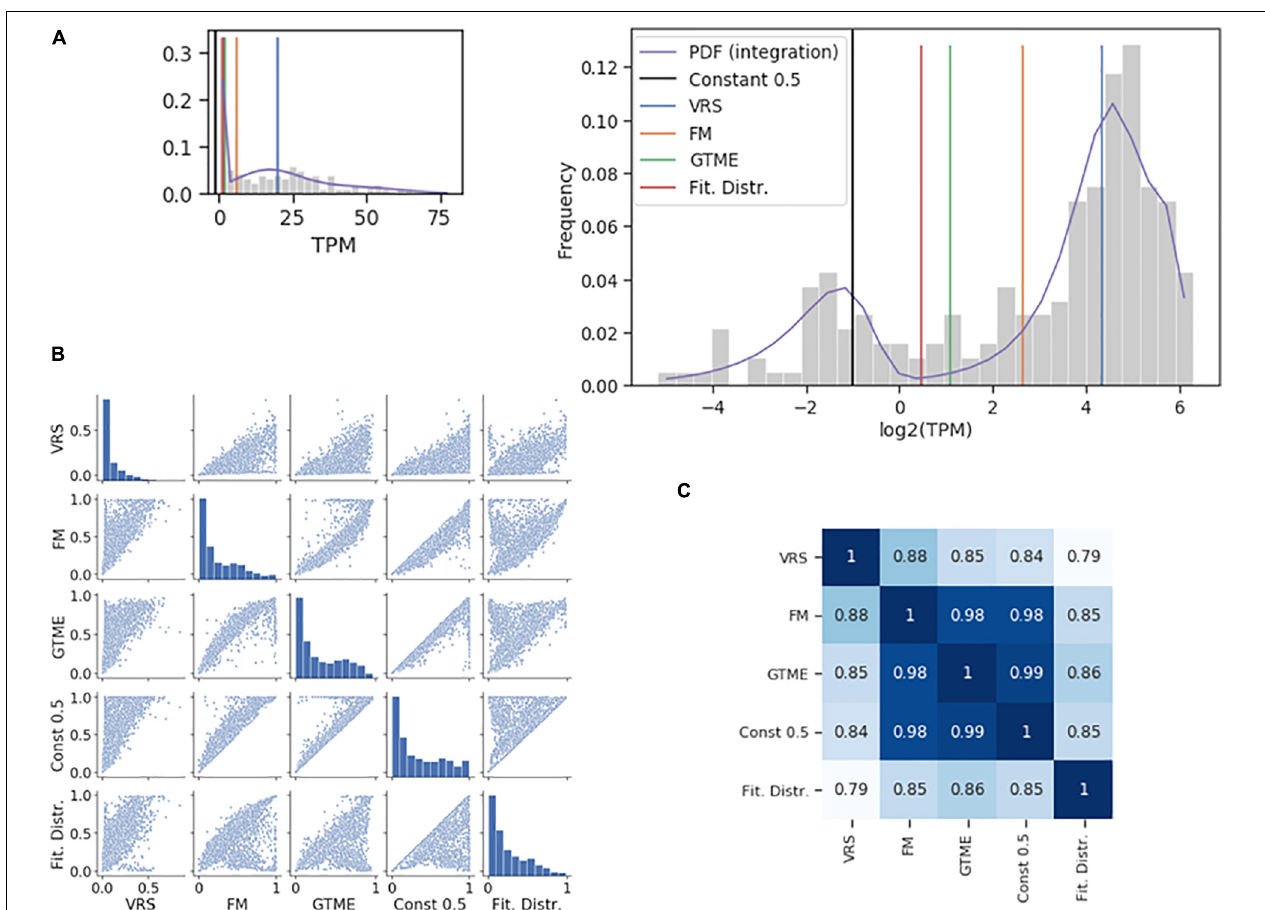
FIGURE 1 | Comparison of dichotomization methods. (A) The histogram of the Pcdhac2 transcript numbers in the somatosensory neurons. The dichotomization yielded the following thresholds: 2.11 (GTME), 6.28 (FM), and 20.21 (VRS) TPM. The fitted probability density function (pdf) is a mixture of normal distributions, with an antimode at 1.37. The pdf is integrated piecewise according to the logarithmic bins. The thumbnail plot is a version of the main plot with a linearly scaled x -axis. (B) Pair-wise scatter plots showing the ON cell frequencies of each gene in the somatosensory neuron dataset with a bimodality coefficient greater than 0.55, after dichotomization with different methods. (C) The Spearman rank correlation of the ON cell frequencies shown in (B) .